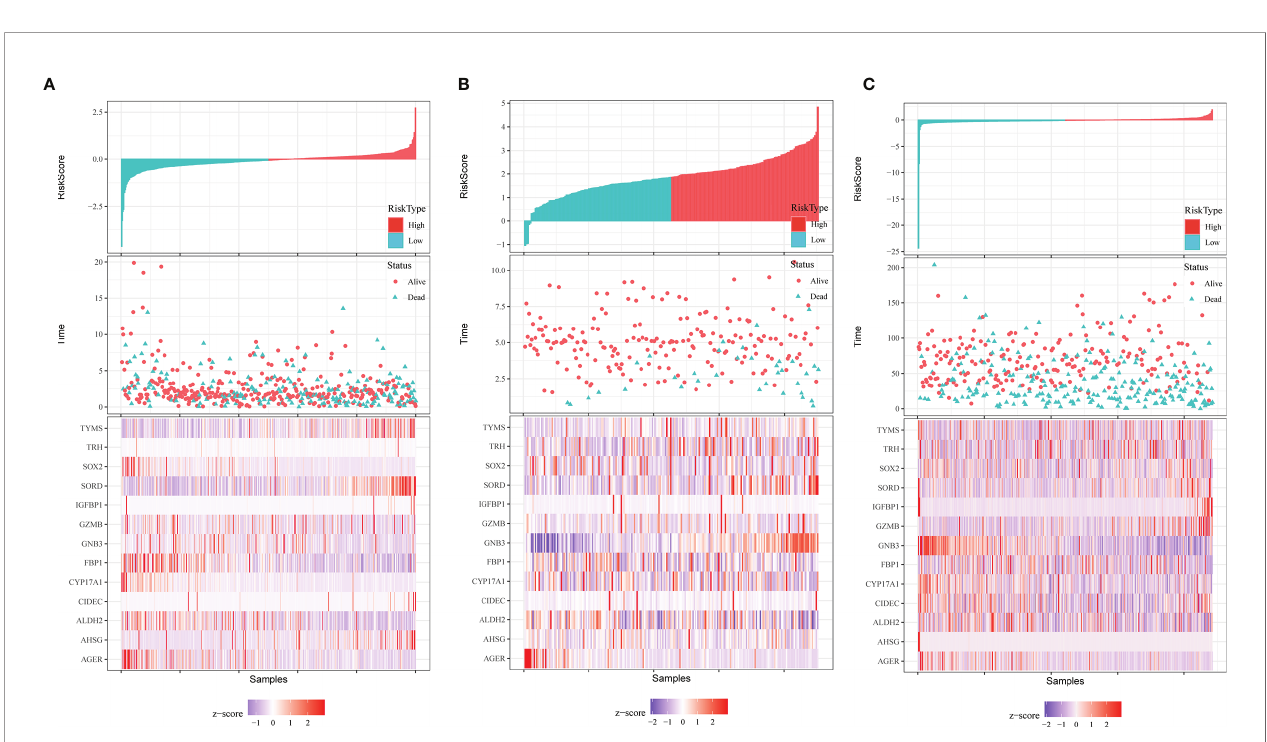
FIGURE 3 | Distribution of risk score, OS, survival status (red dots indicate alive, blue dots indicate death) and the thirteen genes expression heatmaps in TCGA data (A) , GSE31210 (B) and GSE68465 (C)